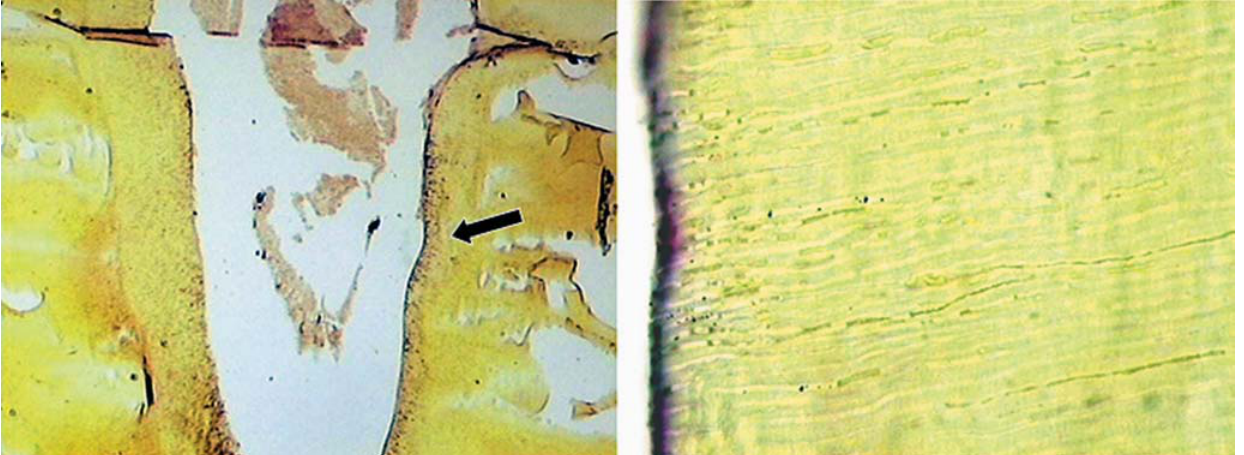
FIGURE 5 - A - SEM micrograph of cervical region of the same specimen shown in Fig. 4, belonging to the control group. Observe the presence of microorganisms within lumen, canal walls and dentinal tubules (arrow). B&B. 40X. B – Close-up view. B&B. 400X